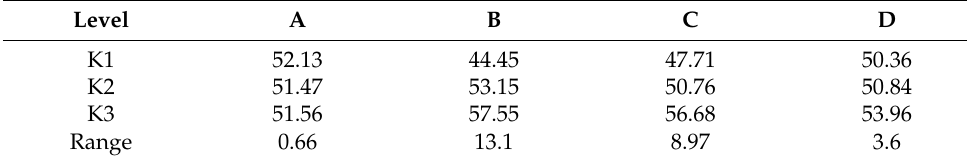
Table 7. Range analysis table of influencing factors of FLU.